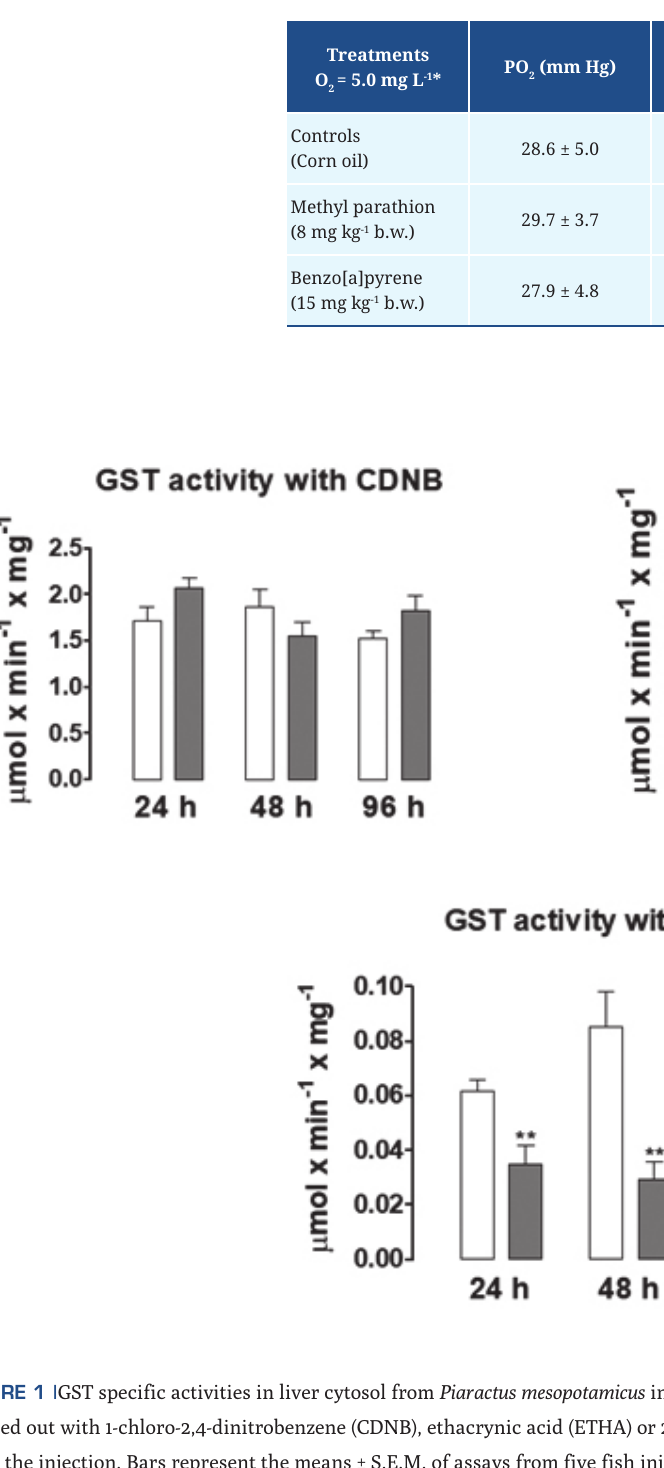
), carbon dioxide partial pressure (PCO 2